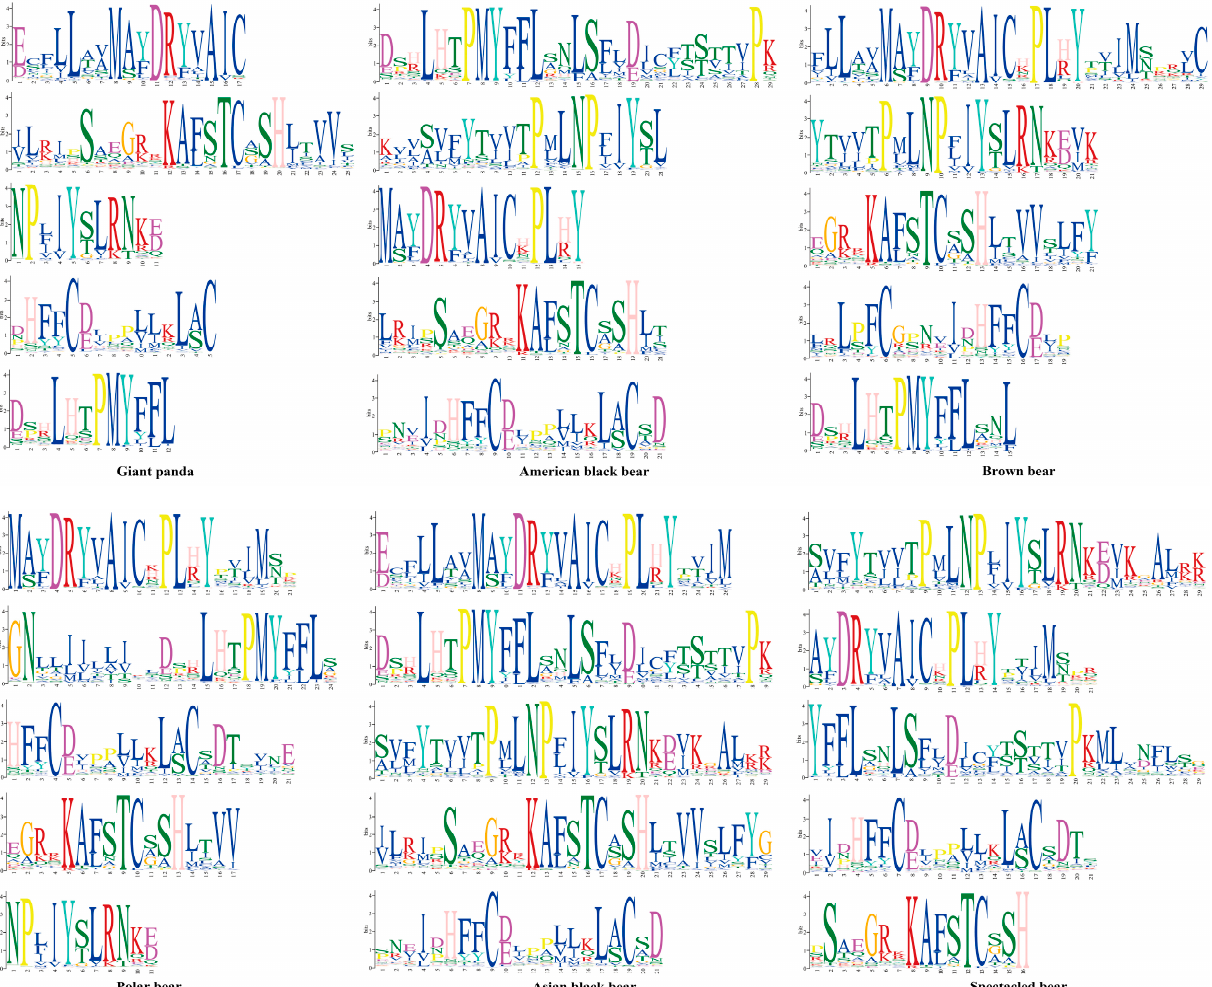
Figure 6. The five most conserved motifs of functional OR genes in six animals. The high degree of amino acid coding represents the degree of conservatism.